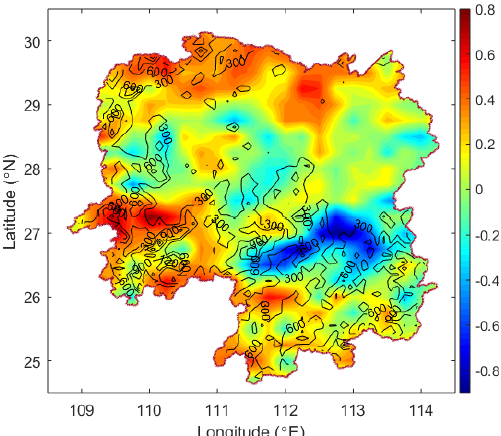
Figure 11. Map of the correlation coefficient between precipitation and PWV for the heavy rainfall process of 6–8 June 2015 over the Hunan Province. Black contours represent the elevation (unit: m). The correlation coefficients were calculated for the accumulated precipitation and PWV for the 6–8 June 2015